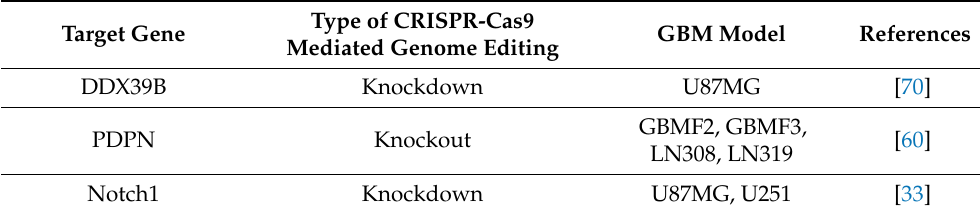
Table 4. CRISPR-Cas9 mediated knockouts of angiogenesis genes in